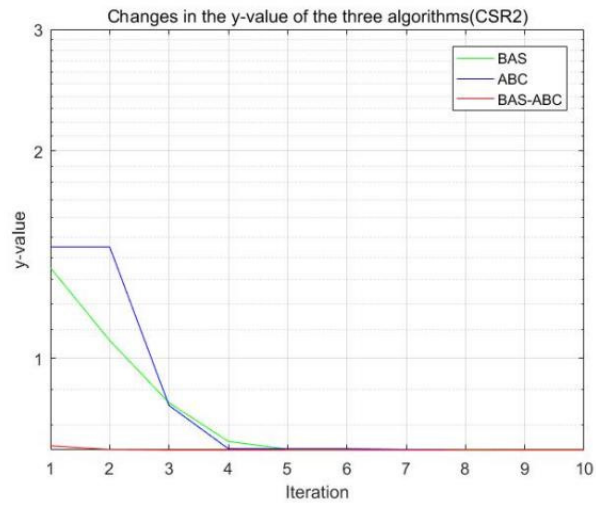
Figure 11. Changes in the 𝑦 value of the three algorithms (CSR2).